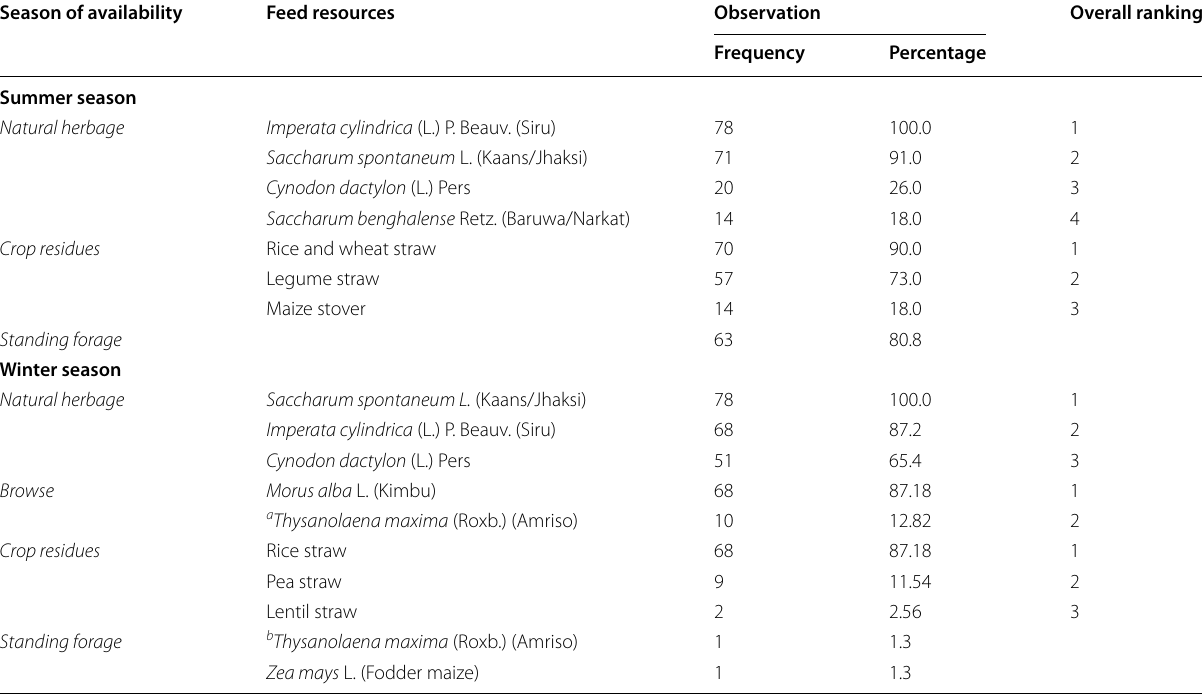
a Collected from river banks and forests as an adaptive regenerated species b